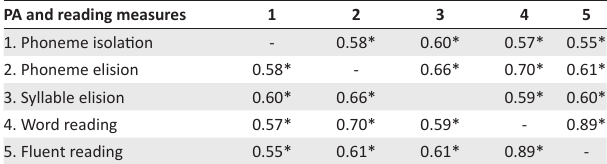
TABLE 2: Spearman rho correlations between phonological awareness and reading measures. PA and reading measures